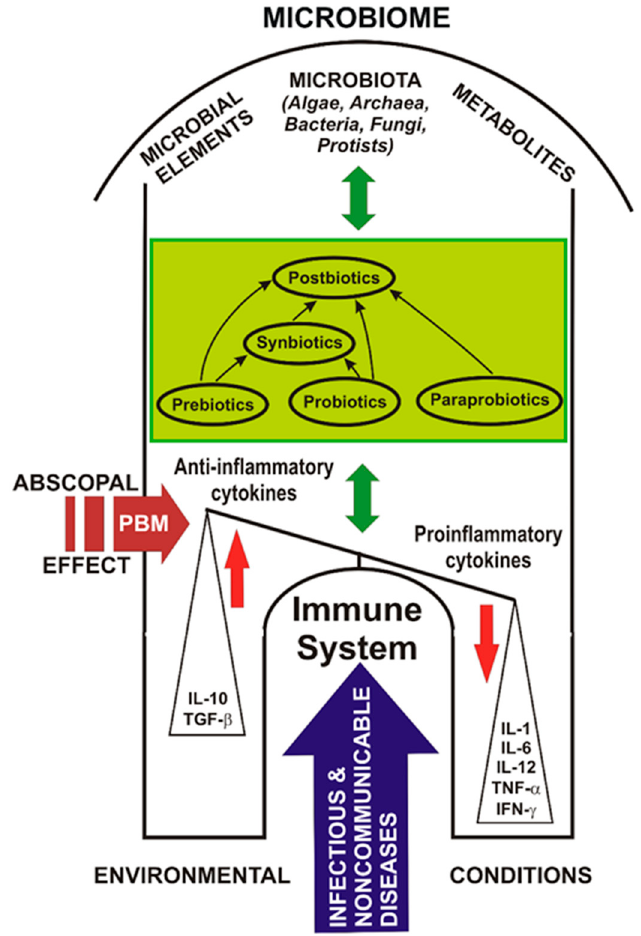
Figure 1. Probiotics, photobiomodulation, and the microbiome in